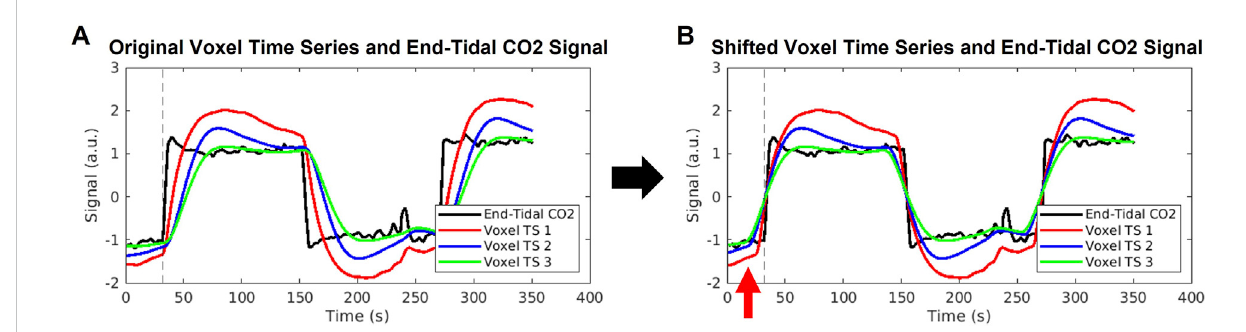
FIGURE 7 Illustrationoferrorsstemmingfromcross-correlation methodofdelaytimes. (A) Anexample end-tidal CO 2 time seriesisshown inblack, withthree example voxel time series shown in red, blue, and green. These voxel time series are created by convolution of the black end-tidal CO 2 time series with threedifferenthemodynamicresponsefunctionsrepresentativeofdifferentareasofthebrain,asusedinYaoetal.(2021).Thecommonbreakpointforall signals is illustrated by the dashed vertical line. (B) The voxel time series are shifted according to the maximum cross-correlation method, which aligns the signals such that maximum correlation with the end-tidal CO 2 time series is achieved. The same end-tidalCO 2 breakpointas in (A) is shown by thedashedverticalline.The redarrowhighlights that thevoxeltimeseries nowdisplaybreakpointsoccurringbeforetheend-tidal CO 2 increase,whichis not possible. The red, blue, and green voxel time series were shifted to the left by 7, 16, and 19 s, respectively, which represent unrealistically high delay